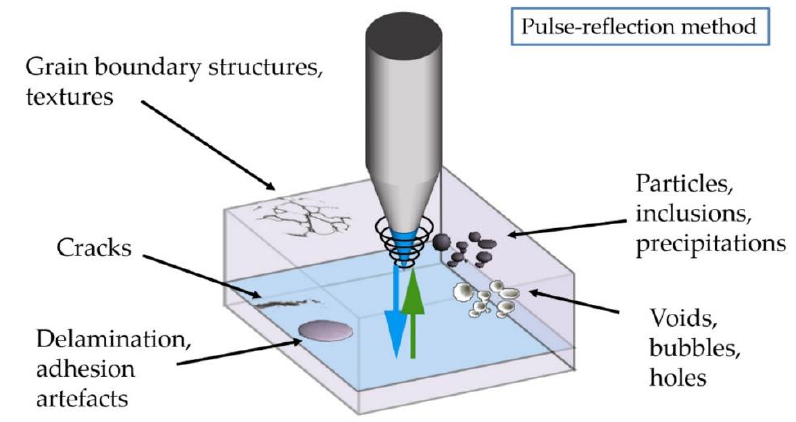
Figure 2 . Defect detection and sample interaction (image courtesy of PVA TePla Analytical Systems).